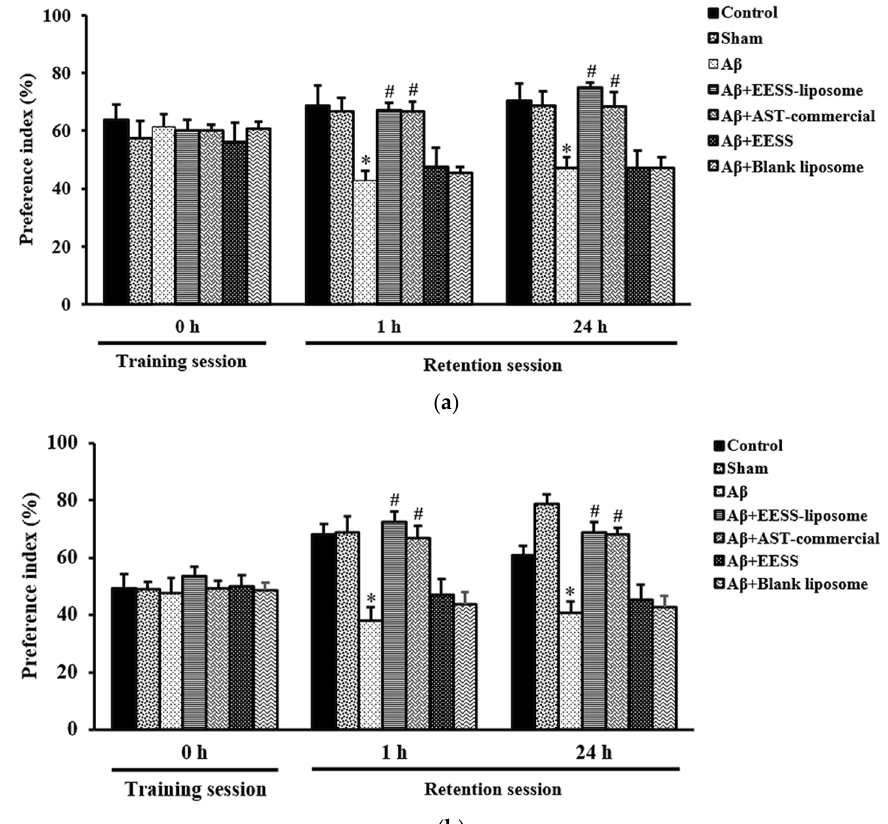
Figure 6. EESS-loaded liposome improved spatial memory in the MWT. ( a ) Escape latency (sec) at 2 and 4 weeks after A β infusion and ( b ) time in target quadrant (sec) at 2 and 4 weeks after A β infu- sion. Data were presented as means ± SEM. * indicates significant difference ( p < 0.05) between A β and sham groups; # indicates significant difference ( p < 0.05) between EESS-loaded liposome, AST-commercial and A β groups; n = 6 rats/group.